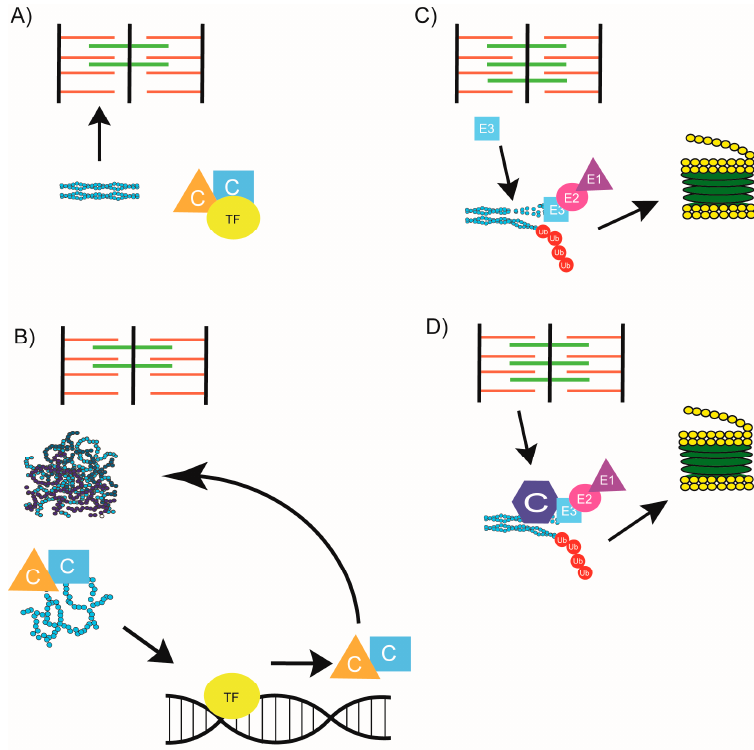
Figure 5. Damaged protein response in sarcomere assembly and maintenance. ( A ) In a healthy assembling sarcomere, chaperones (C) fold and incorporate muscle proteins; ( B ) when protein damage occurs during sarcomere assembly, chaperones dissociate from their complex to bind client proteins. Transcription factor (TF) translocates to the nucleus and initiates transcription of chaperones [61]. When protein damage occurs during sarcomere maintenance, either ( C ) a chaperone independent response occurs by which E3 ligases target damaged proteins and mark them for degradation or ( D ) a chaperone dependent response occurs by which chaperones and the UPS cooperate to target damaged proteins to the